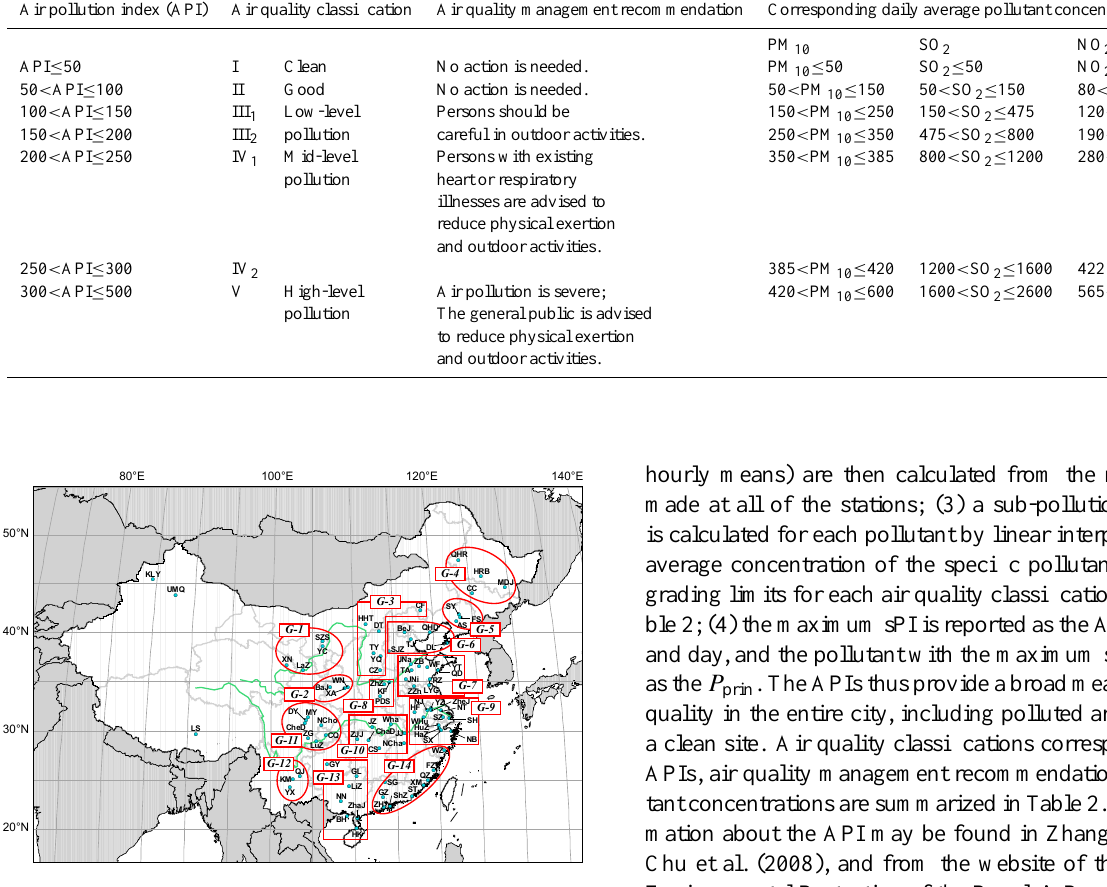
Fig. 1. Locations of the eighty-six Chinese cities for which data are available. Full names of these cities are listed in Table 1. Red frames labeled with G-1 through to G-14 include the cities assigned to the specific group as in Table